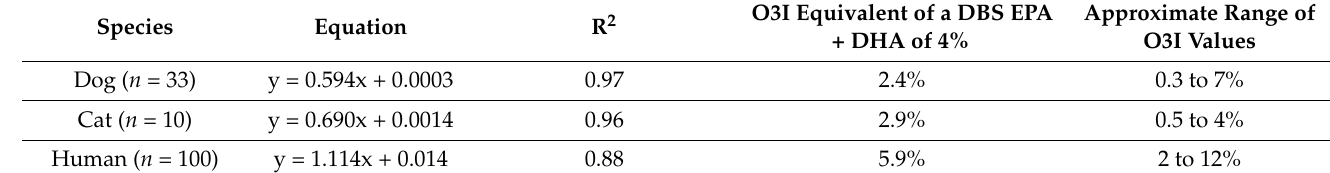
Table 1. Equations to convert DBS EPA + DHA (x) into the Omega-3 Index (RBC EPA + DHA %) (y) by species.